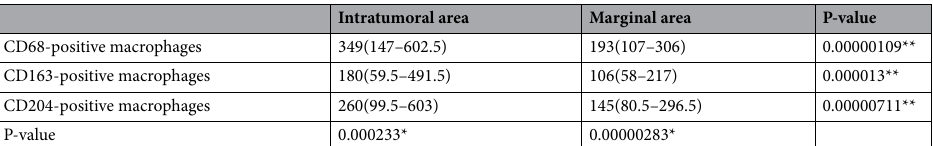
Table 2. Number of CD68-, CD163-, or CD204-positive macrophages in the intratumoral and marginal areas. All parameters are expressed as the median, and 25th and 75th centiles. *Friedman rank sum test (with post- hoc Bonferroni correction). **Wilcoxon signed rank